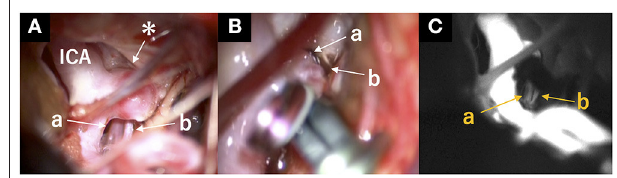
FIGURE 2 | Intraoperative view. (A) Intraoperative view indicated the structures surrounding the aneurysm before clipping. *: aneurysm; a: anterior choroidal artery; b: duplicated middle cerebral artery. (B) Two titanium clips were combined and applied to occlude most part of the aneurysm, while confirming the patency of the DMCA and the AChA. a: Anterior choroidal artery; b: duplicated middle cerebral artery. (C) Patency of the duplicated middle cerebral and anterior choroidal arteries was confirmed using indocyanine green video angiography after clipping. a: anterior choroidal artery; b: duplicated middle cerebral artery.